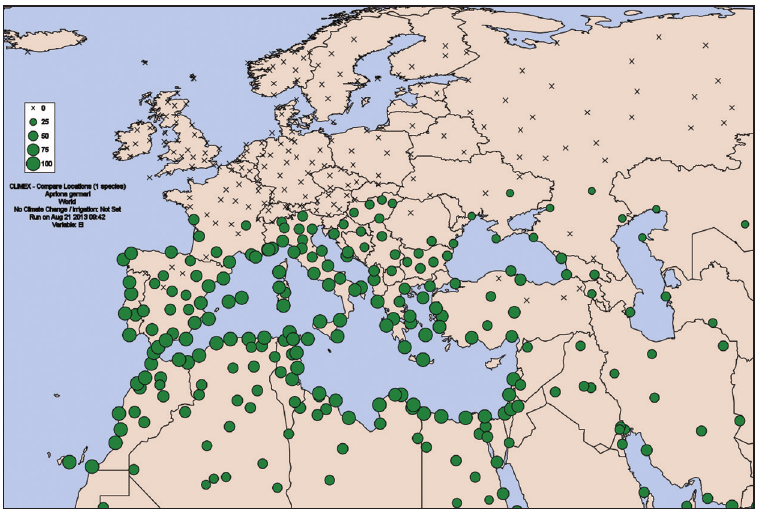
Figure 4. Potential distribution of Apriona germari in Europe based on a CLIMEX model with the hypothesis of a 3 year life cycle (1295 DD/year). The Ecoclimatic index (EI) indicates the climatic suit- ability for establishment. Crosses indicate unsuitable locations (EI=0). Green dots indicate the degree of climate suitability. The minimum threshold temperature for development in all models was 12 °C, based on Ibáñez et al. (2010).